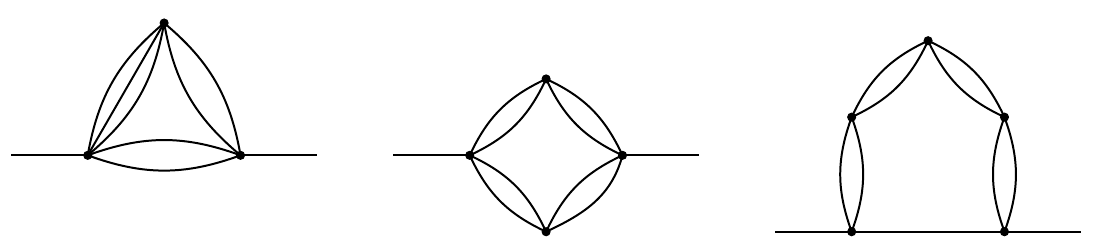
Figure 7 . Three examples of recursively one-loop master integrals. Each loop variable can be integrated one by one, and in the end we obtain an exact expression for each of these integrals as a function of the spacetime dimension d